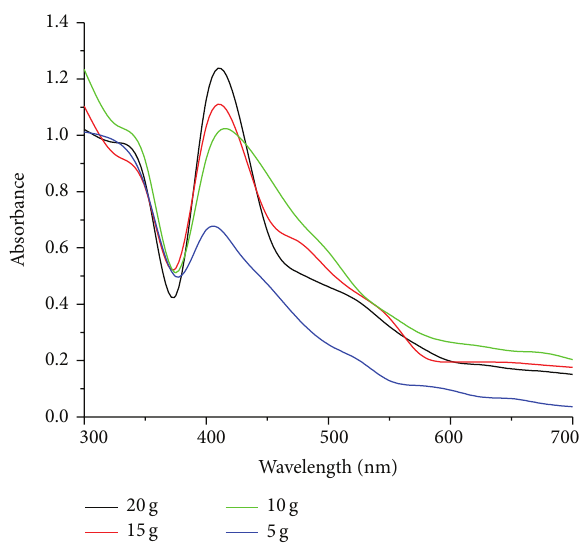
Figure 6: UV-visible absorption spectra of AgNps at different biomass concentrations.